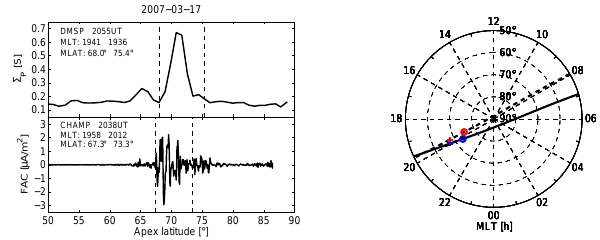
Figure 10. (left) Latitude profiles of Pedersen conductance, 6 P , es- timated from DMSP F15 obserservation (top) and CHAMP FAC Fig. 10. (left) Latitude profiles of Pedersen conductance, Σ P , estimated from DMSP F15 obserservation (top) observations (bottom) almost at the same time on 17 March 2007. and CHAMP FAC observations (bottom) almost at the same time on March 17, 2007. (right) The trajectories of (right) The trajectories of DMSP (dashed) and CHAMP (solid); the DMSP (dashed) and CHAMP (solid), the equatorward and poleward boundaries of the auroral oval have been equatorward and poleward boundaries of the auroral oval have been marked as crosses and circles, respectively, with different colors on the trajectories (red for DMSP and blue for marked as crosses and circles, respectively, with different colours CHAMP). on the trajectories (red for DMSP and blue for CHAMP).